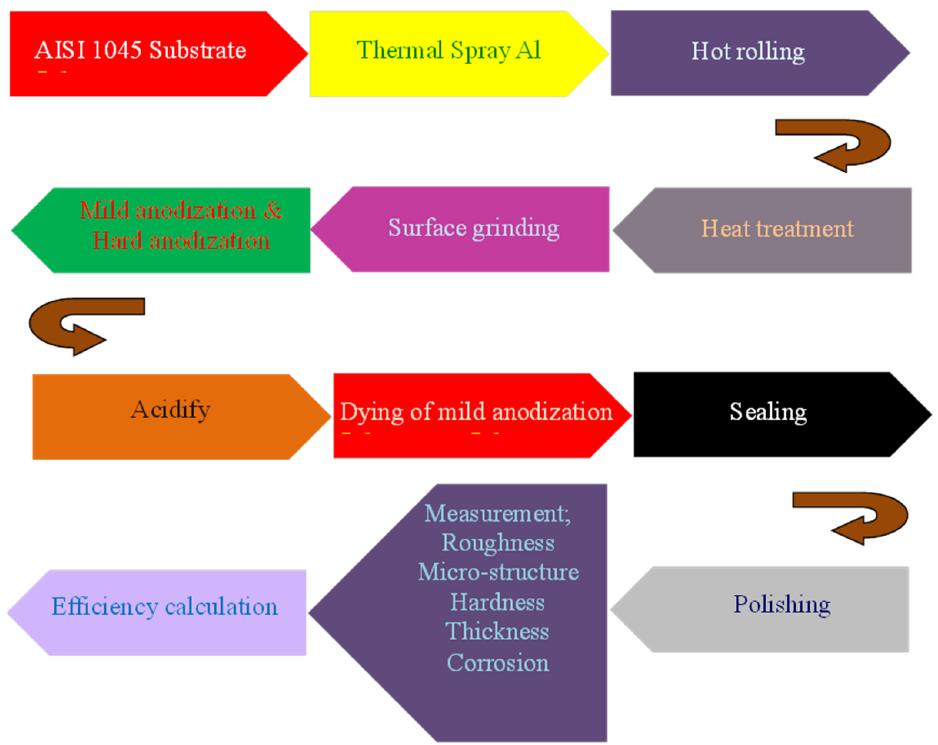
Figure 1. Flow chart illustrating the entire experiment process.